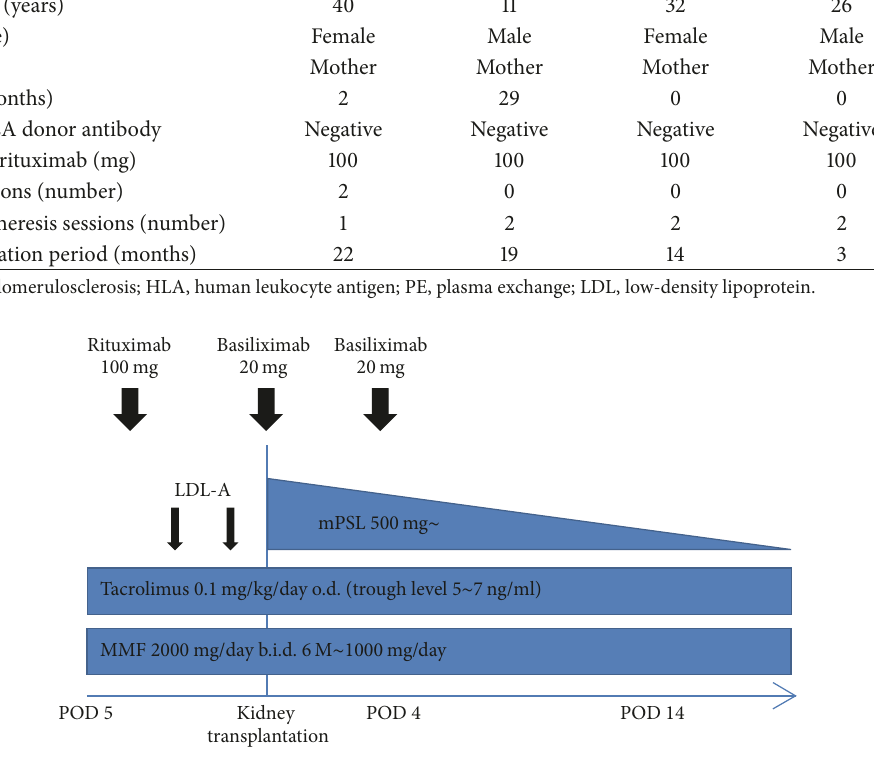
Figure 1: Immunosuppressive therapy for kidney transplantation and LDL apheresis to prevent recurrence of FSGS. LDL-A, low-density lipoprotein apheresis; mPSL, methylprednisolone; MMF, mycophenolate